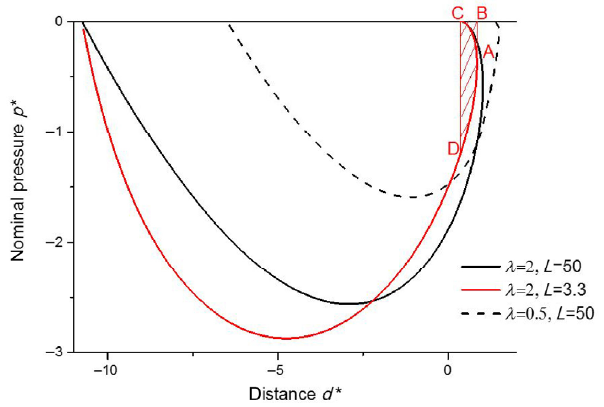
Fig. 3 Energy dissipation per unit area in the approach–separation cycle of rough